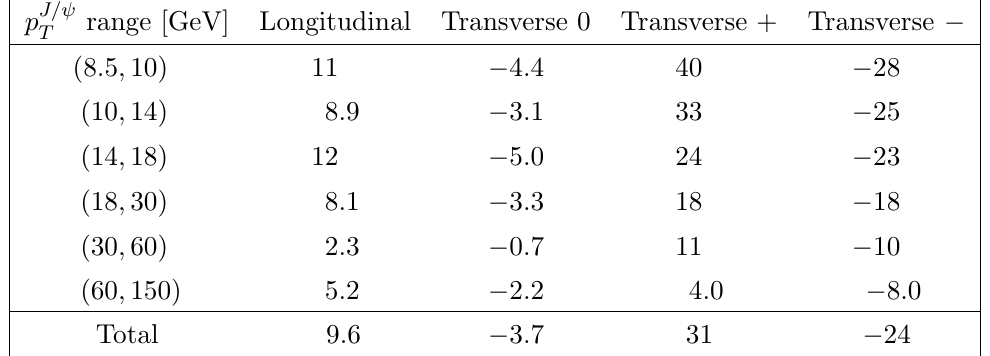
Table 4. Percentage variations on the di(cid:11)erential distribution for four extreme cases of J= spin alignment of maximal polarisation relative to the nominal unpolarised assumption for j y